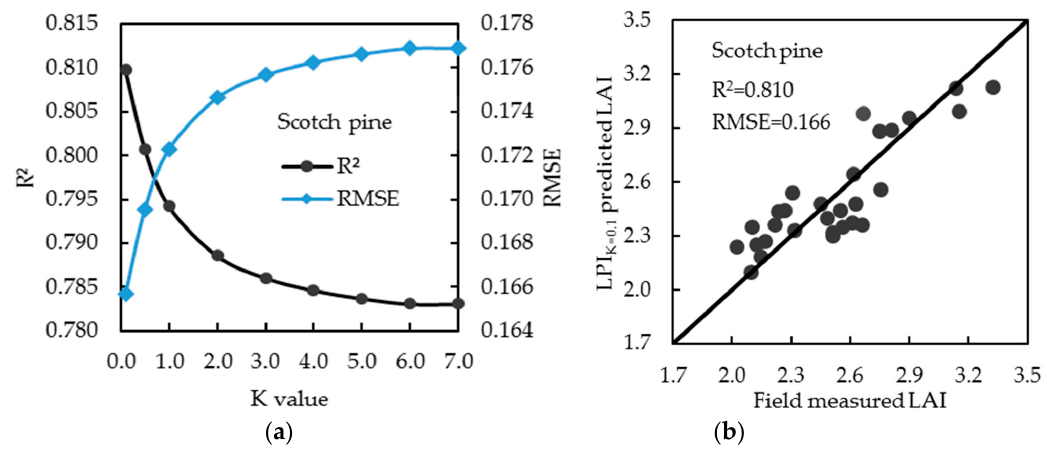
Figure 8. The LAI estimation results for Scotch pine forests with target reflectance normalisation: ( a ) LAI estimation accuracy with different K values; ( b ) The relationship between the field-measured LAI and LiDAR-predicted LAI when the K value was set to around 0.1 (i.e., LPI K=0.1 ). R 2 and RMSE are values from leave-one-out cross-validation.